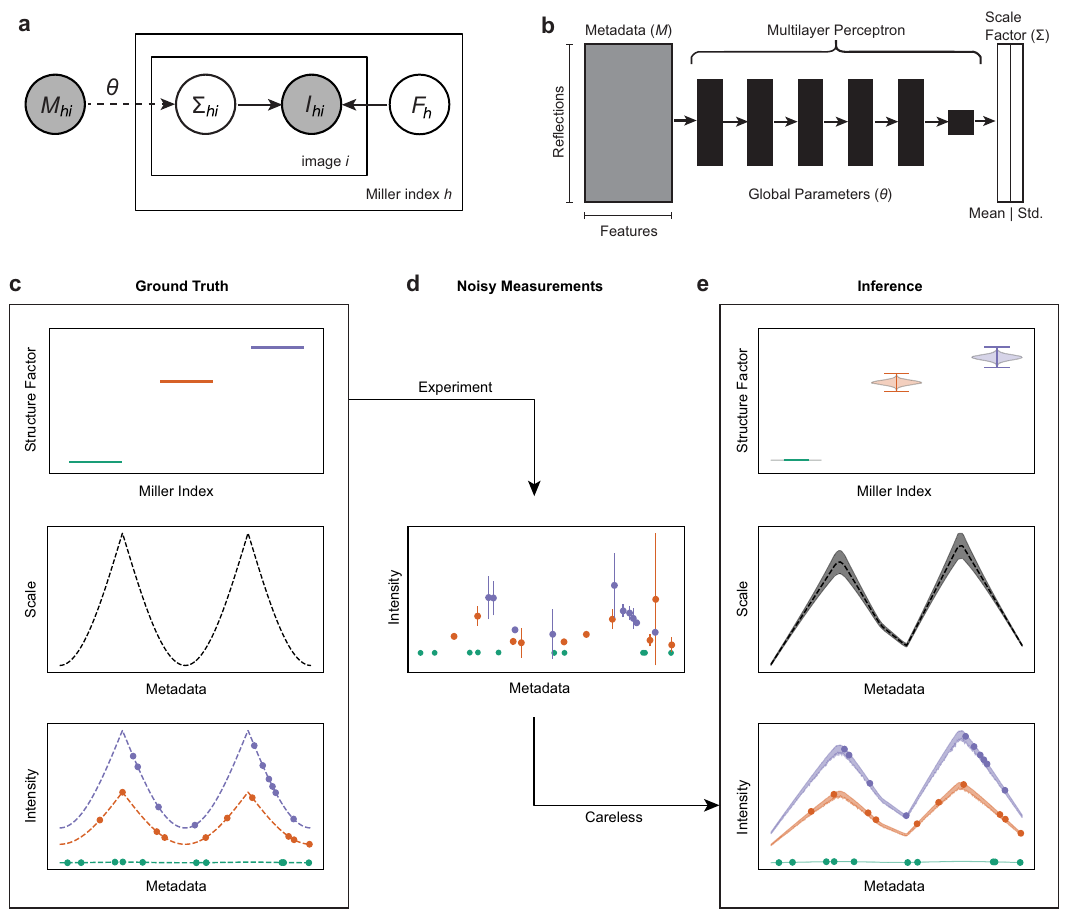
Fig. 2 | Estimation of scales and structure factor amplitudes from simulated the measurement errors in a diffraction experiment (ten per structure factor). data.a Aprobabilisticgraphicalmodelsummarizesourbasicstatisticalformalism: Shownaresimulatedmeasuredvalues.Errorbarsindicate95%con fi denceintervals. e This statistical model allows for joint, rather than sequential, inference of the Careless calculates a probabilistic scale, Σ , as a function of the recorded metadata, h andimage M ,andlearnedparameters, θ .Observedintensities, I h posterior distributions of structure factor amplitudes and scales, and therefore of , i ,forMillerindex i are modeled as the product of the scale and the square of the structure factor implied intensity (bottom panel). The violin plots in the top panel show the pos- amplitude F h ,thatis,as Σ h , i (cid:1) F 2 h . b Theglobalscalefunctionthatmapstherecorded terior probability with whiskers indicating the extrema of 10,000 samples drawn metadata to the probabilistic scale, Σ , takes the form of a multilayer perceptron. from the posterior distribution of the inferred F . Shaded bands indicate 95% con- fi dence intervals around the posterior means. The posterior mean of the scale c – e Inference of scales and structure factors from simulated data comprising 10 draws from the ground truth model. ( c ) Input parameters for the simulated data functionisindicatedasadashedline(middlepanel),andtheposteriormeanforthe were chosen to recapitulate the non-linear scales observed in diffraction data. re fl ection intensities are shown ascircles (bottom panel).For this toyexample, the d Noisy observations were generated from these input parameters, which re fl ects inferred values in ( e ) can be compared to the known ground truth in ( c